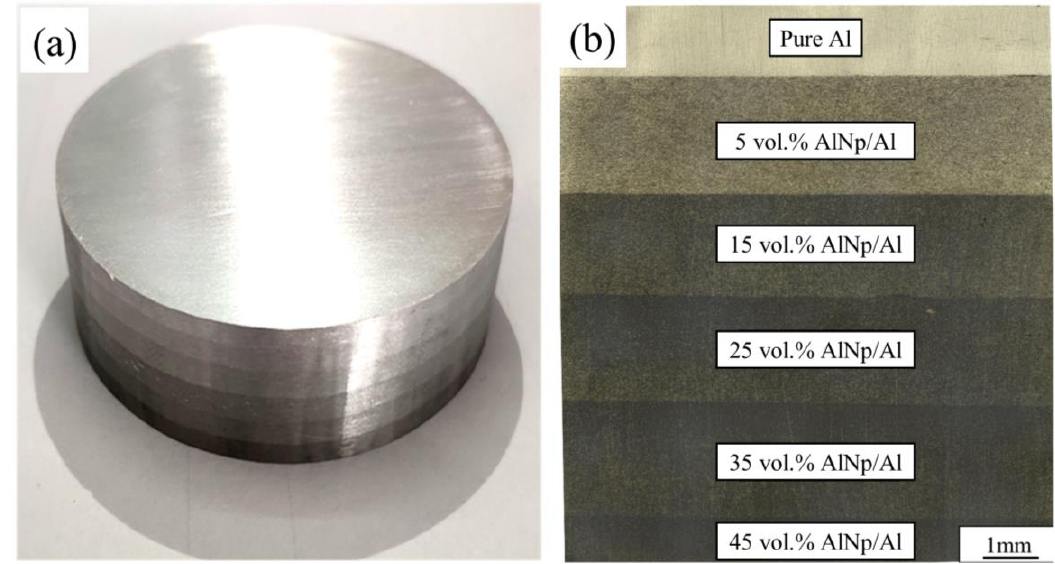
Figure 7. ( a ) Sintered gradient AlN/Al composites with a size of φ64 mm × 18 mm; ( b ) metallography image of a six-layer gradient composite.